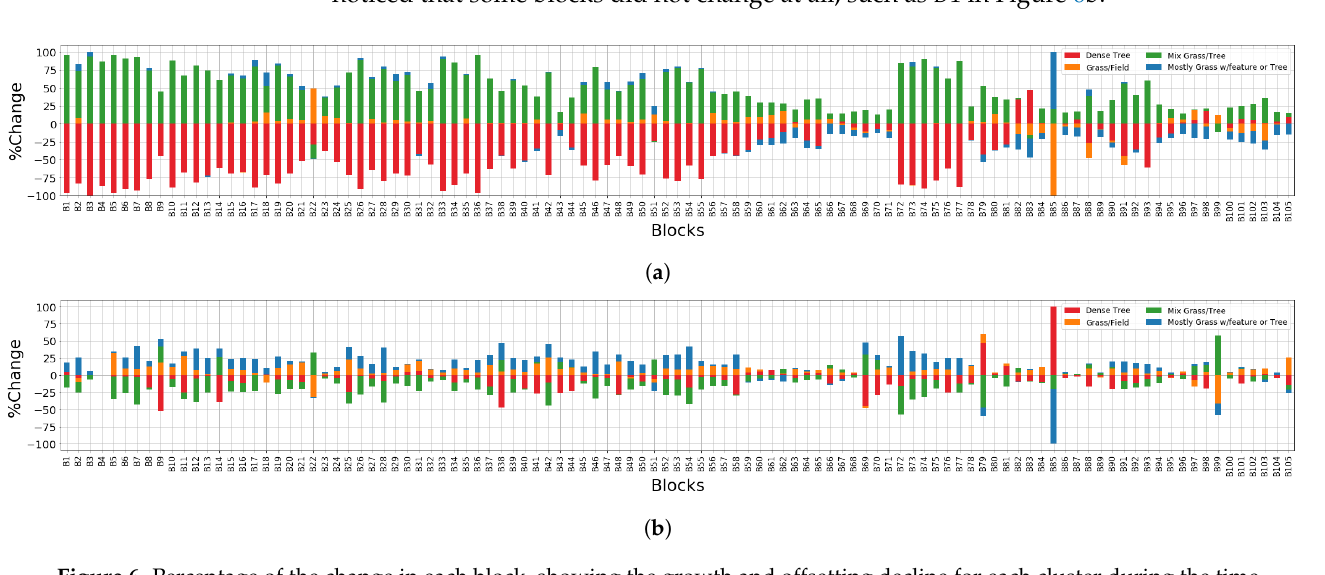
Figure 6. Percentage of the change in each block, showing the growth and offsetting decline for each cluster during the time periods: ( a ) 2011–2015. ( b ) 2015–2017. For example, in ( a ), the grass field increases especially in the blocks B17–B62 while it decreases in most of the blocks B63–B104 . In ( b ), it can be noticed that some blocks did not change at all, such as B4